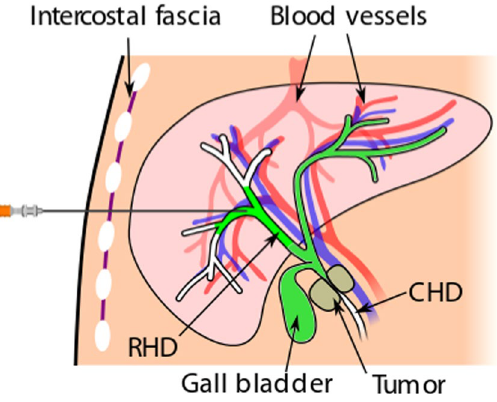
Figure 1. Schematic overview of needle insertion into the right hepatic duct (RHD): A tumor closes the common hepatic duct (CHD) and cholestasis results.